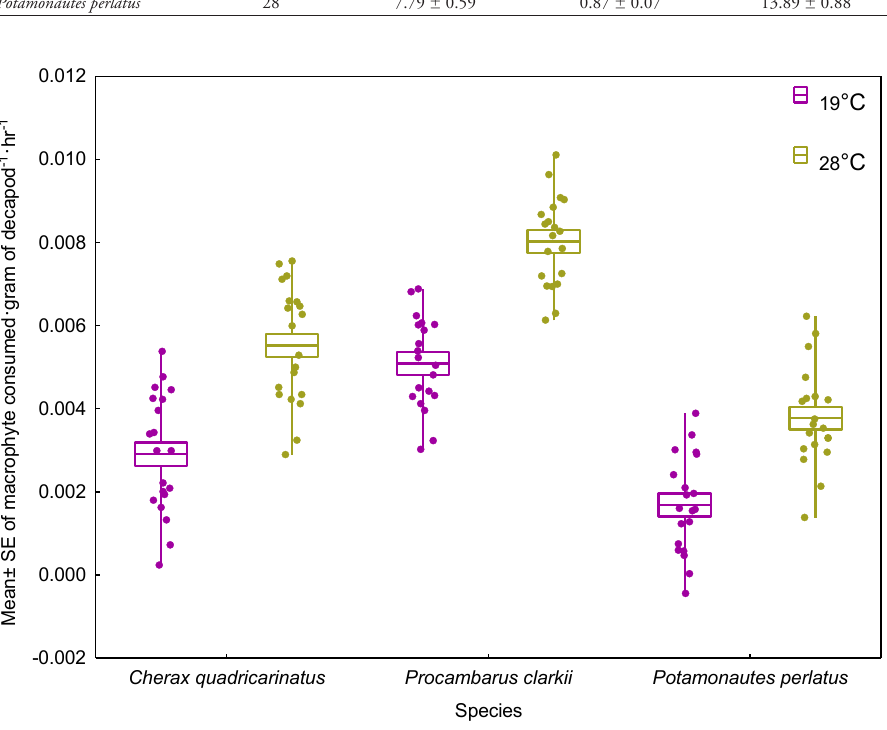
Figure 1. Mean consumption of macrophyte ( Potamogeton nodosus ) per hour per gram of Cherax quadricarinatus , Procambarus clarkii and Potamonautes perlatus at 19°C and 28°C. Points indicate raw data values, boxplots indicate ± Standard Error and solid line across the box represents the mean.